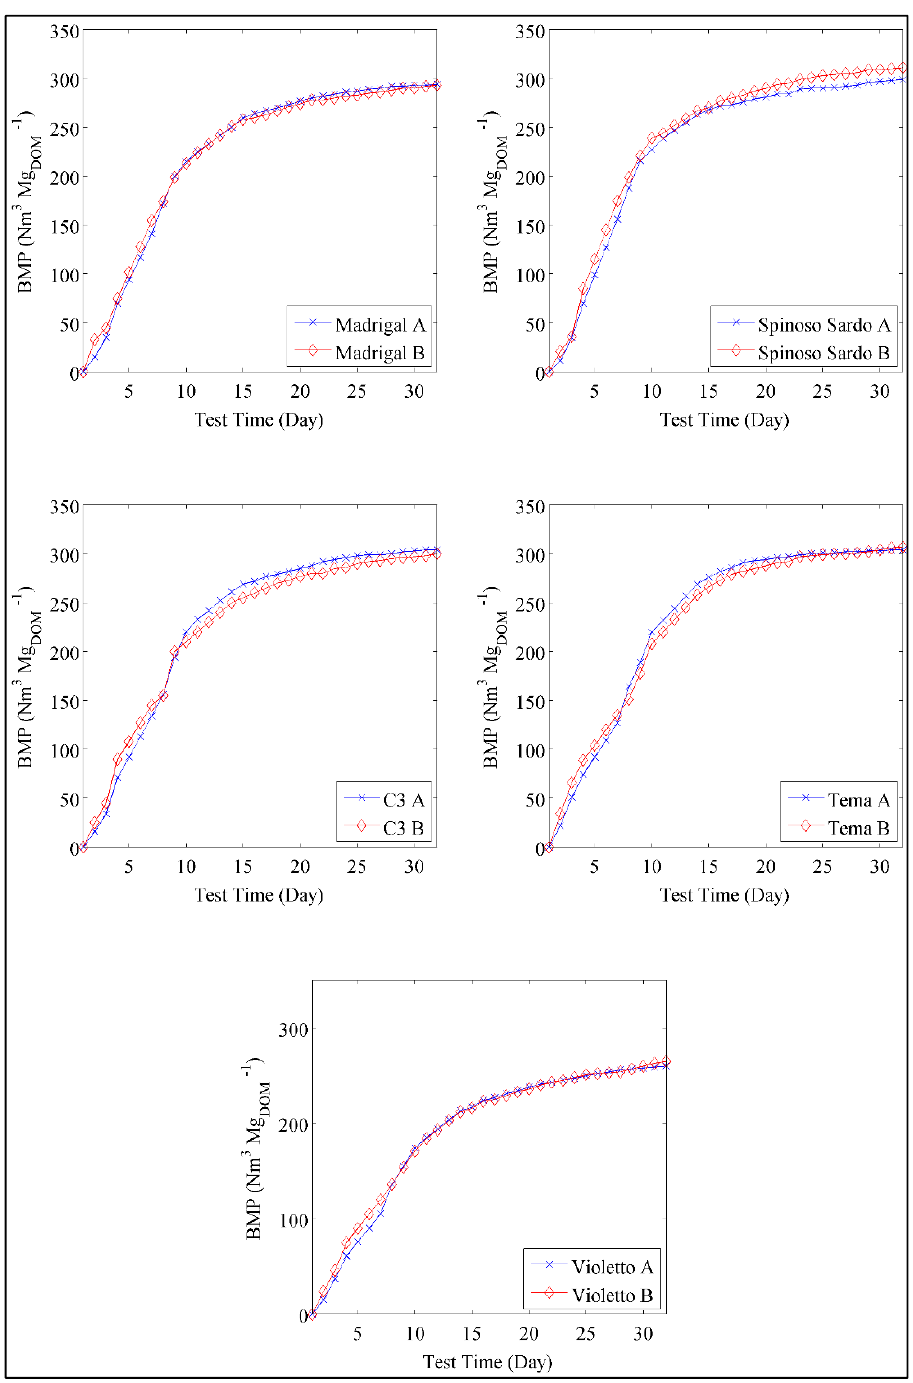
Figure 1. BMP cumulative trends.